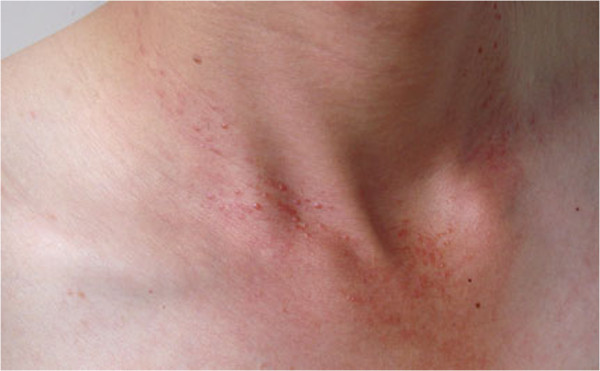
Picture of neck.